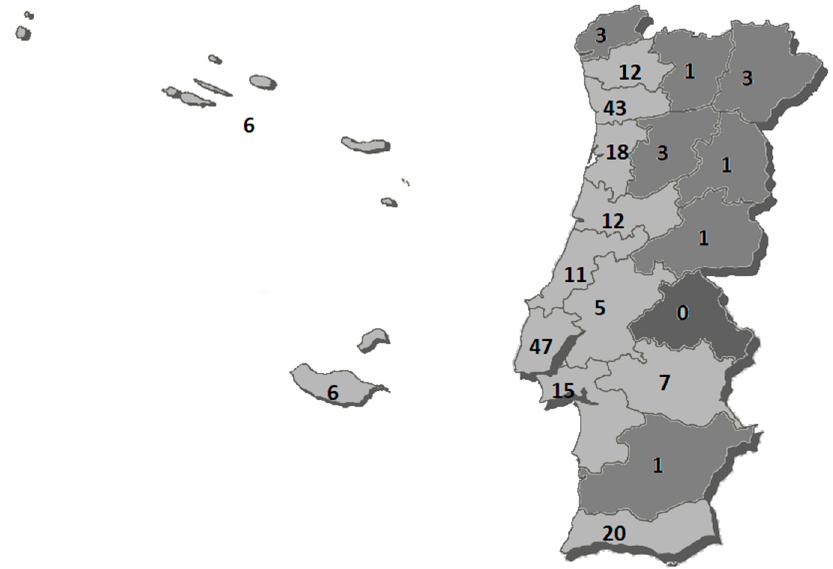
Figure 2. Distribution of adapted sports clubs by districts of Portugal.